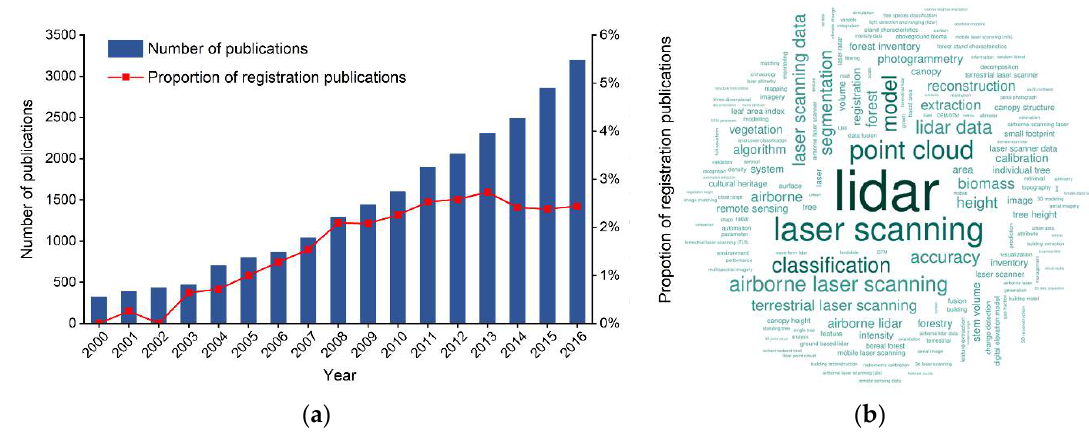
Figure 1. ( a ) Publication statistics; and ( b ) cloud map of high-frequency terms used in LiDAR-related